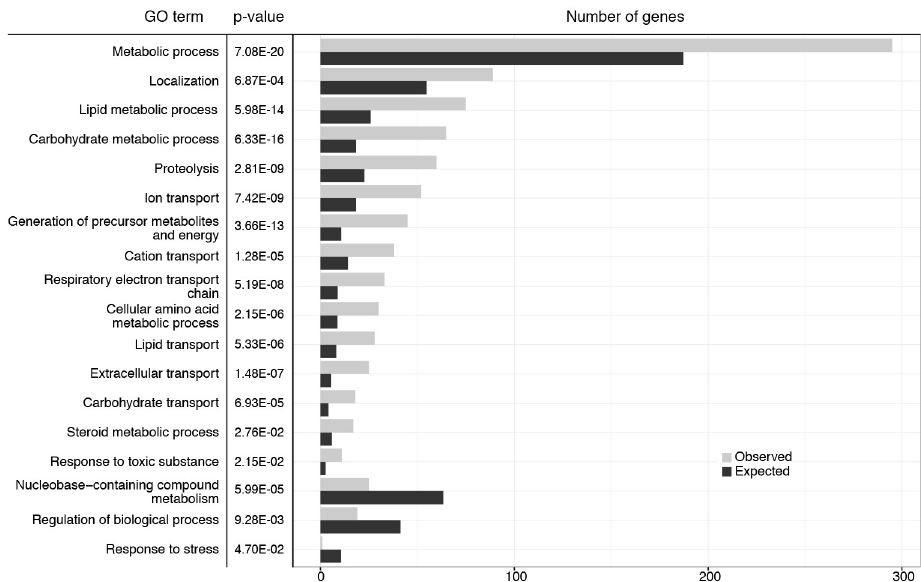
Fig 8. Expression analysis identifies metabolism genes as altered in HP1b mutants. GO terms significantly enriched (top) or depleted (bottom three terms) are reported along with the relevant p-values. The bar graphs show the observed (grey) and expected (black) number of genes associated with each GO term. GO terms show are top level terms from GO SLIM. For the results for all GO SLIM terms, see S2 Table. For the results from the basic GO term analysis see S3 (upregulated genes) and S4 (downregulated genes)